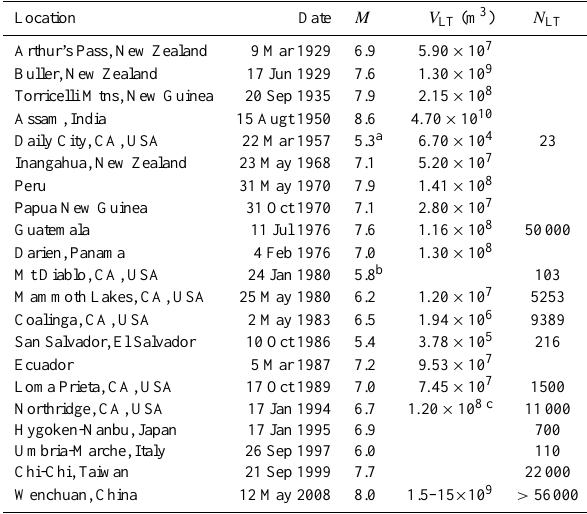
Table 3. Earthquake location, date and moment magnitude, M , with total landslide volume, V LT , and total landslide numbers, N LT , from Keefer (1984) including data from Northridge, CA (Malamud et al., 2004) and Wenchuan, China (various, see text).